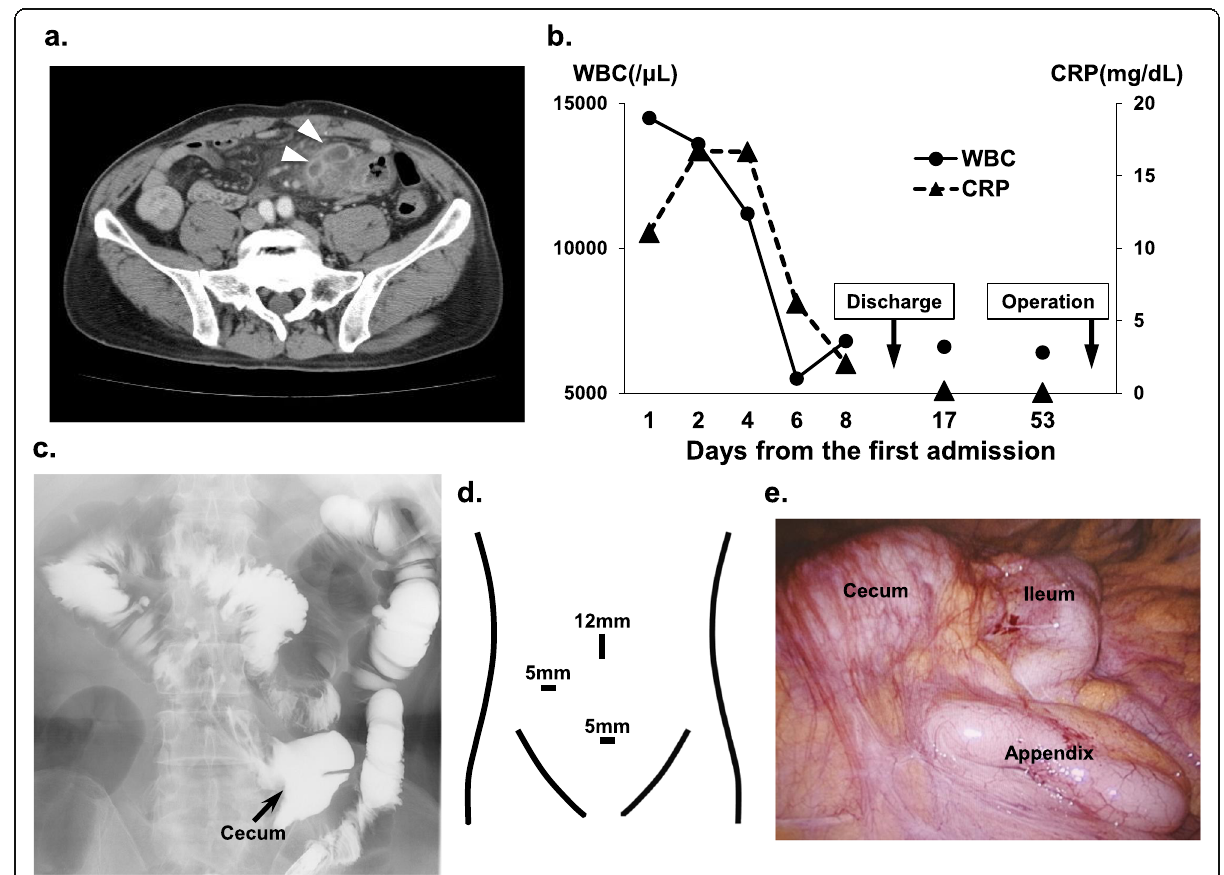
Fig. 1 a CT findings: the cecum was located in the left lower side of the abdomen. The swollen appendix was surrounded by intra-abdominal abscesses (arrow heads). b The clinical course of this patient: he was discharged at day 9 and underwent an interval appendectomy at day 54. c The gastrografin enema findings: the cecum (arrow) located in left-lower side of the abdomen. d The trocar placement of the interval appendectomy: Note the mirror image trocar placement against an ordinal laparoscopic appendectomy. e Intraoperative findings: iliocecal structures were located in the left lower